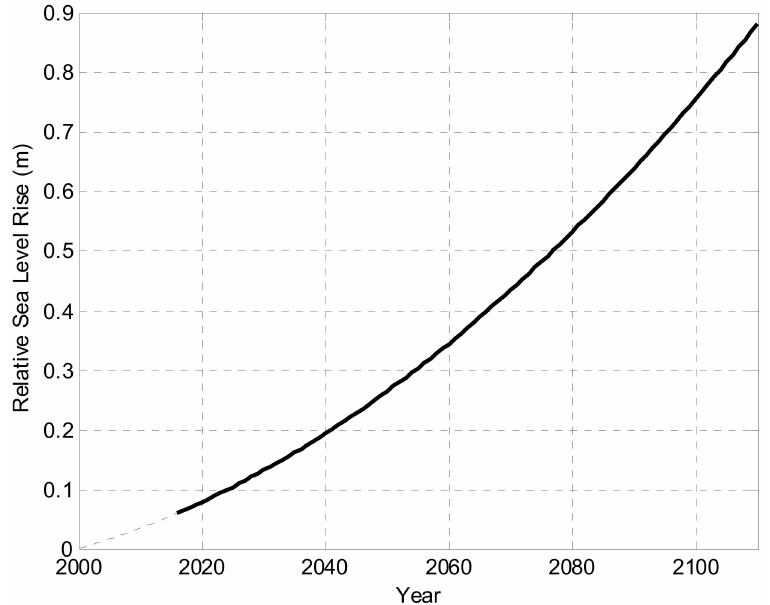
Figure 13. Regional RSLR for RCP 8.5 excluding land subsidence by 2100 (relative to